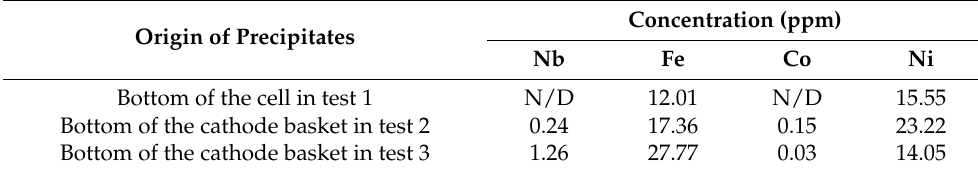
Table 1. Concentrations of Nb, Fe, Co, and Ni in the precipitates after the tests 1–3. Concentration (ppm) Origin of Precipitates Nb Fe Co Ni Bottom of the cell in test 1 N/D 12.01 N/D 15.55 Bottom of the cathode basket in test 2 0.24 17.36 0.15 23.22 Bottom of the cathode basket in test 3 1.26